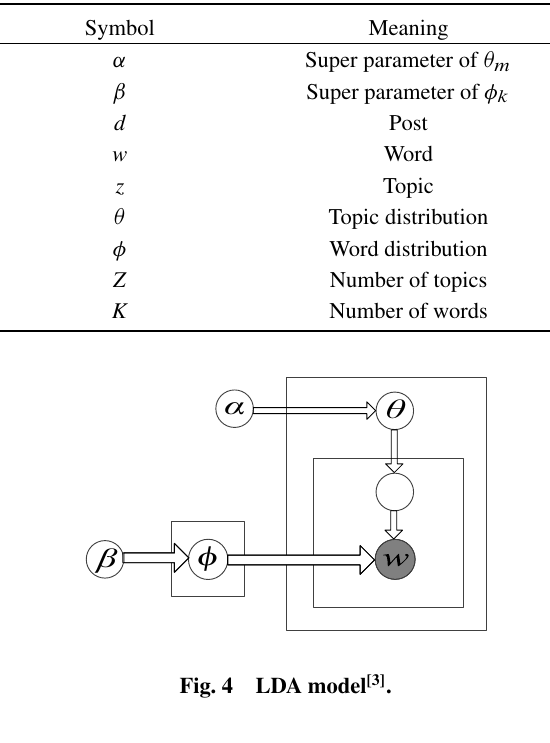
Table 1 Symbols used in the LDA model.